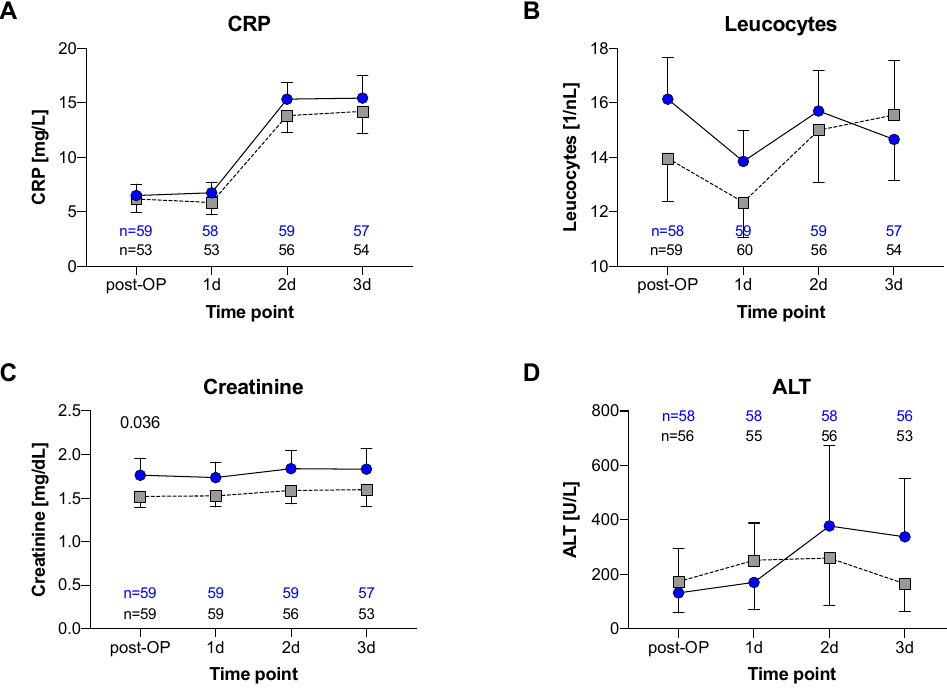
Figure 4. Postoperative variables: Variables are shown with regard to the use of methylene blue versus standard therapy (Matched Control), indicating mean (SD). ( A ) CRP; ( B ) Leucocytes; ( C ) Creatinine; ( D ) ALT.